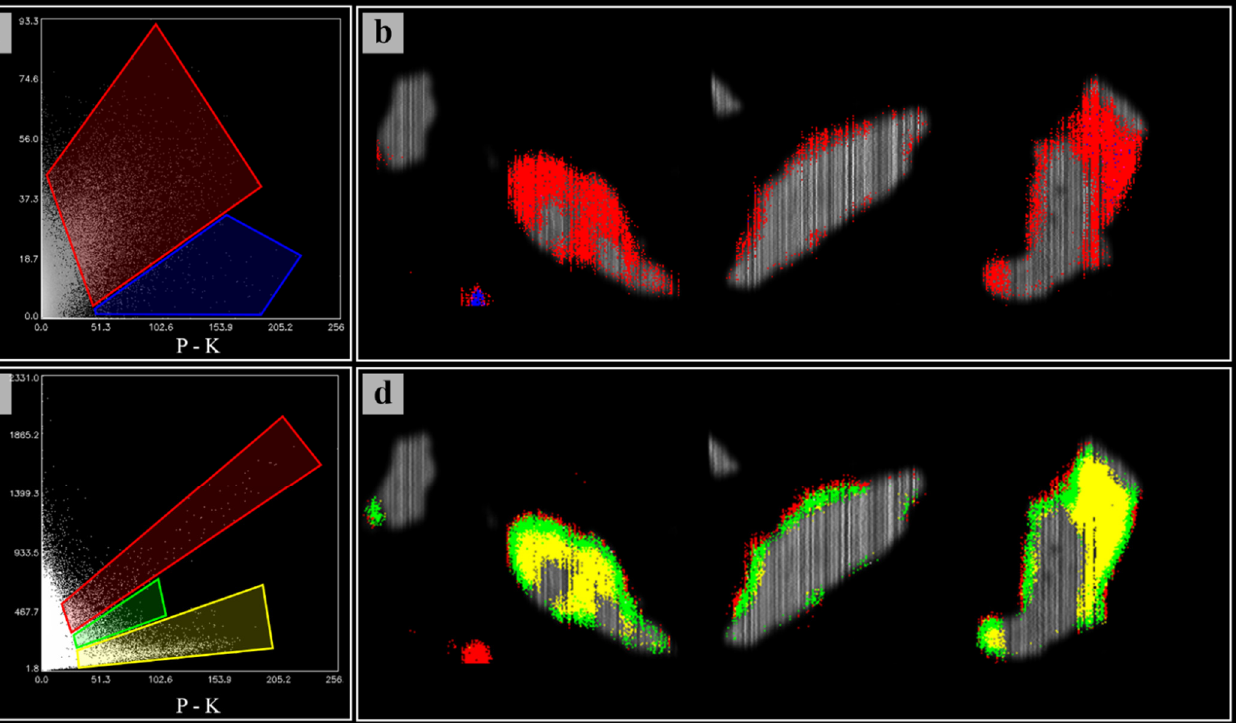
Figure 3. ( a ) Cl (K fluorescent signal) vs. P (K fluorescent signal) and ( c ) Ca (K fluorescent signal) vs. P (K fluorescent signal) scatterplots obtained using spectral µXRF deconvolution data of the three particles of Figure 2. ( b , d ) The three particles colored according to the different Cl–P and Ca–P correlations identified through the scatterplots (the background grey micrographs corresponding to Pb–L signals).